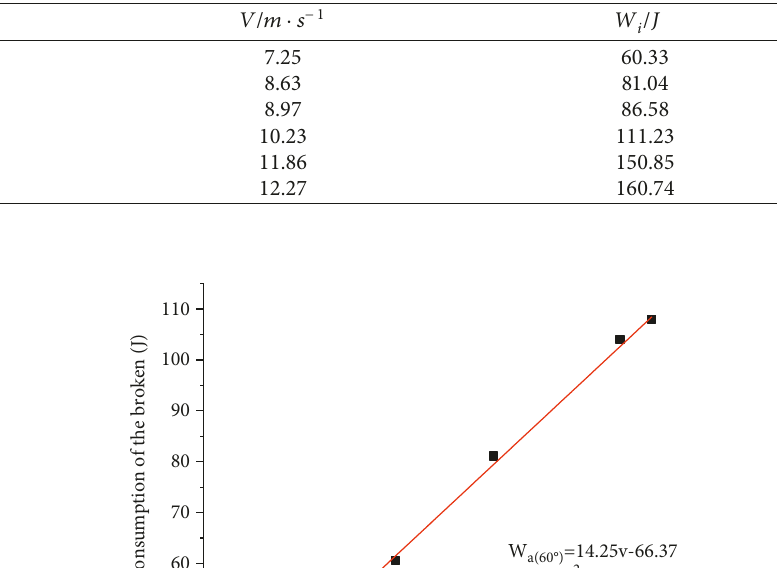
Table 2: Test data of dynamic point load test at the conical angle of 60 ° .